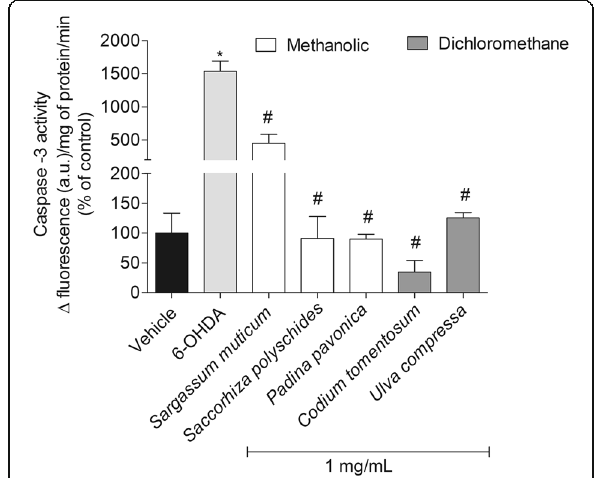
Fig. 6 6-OHDA (100 μ M) effects in the presence or absence of seaweeds extracts (1 mg/mL) on Caspase-3 activity of SH-SY5Y cells after 6 h of treatment. The activity was quantified by the slope of the linear phase accumulation of Rhodamine 110 (between 20 and 40 min). The results are presented in arbitrary units of fluorescence per mg protein. The values in each column represent the mean ± standard error of the mean (SEM) from 3 to 4 experiments. Symbols represent statistically significant differences ( p < 0.05, ANOVA, Dunett ’ s test) when compared to: * vehicle. # to